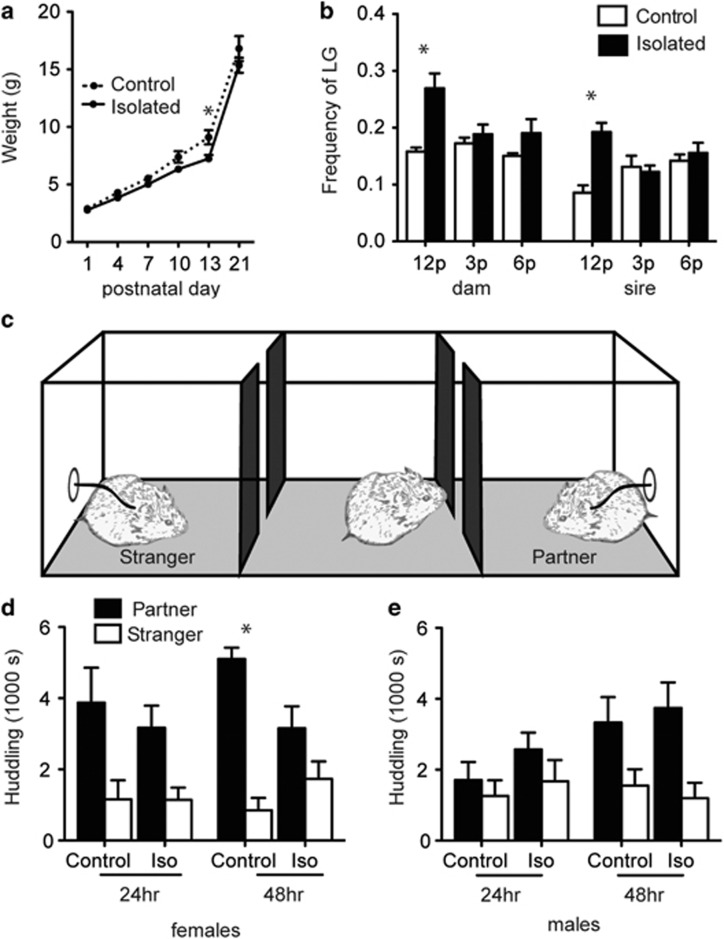
Impact of early isolation on weight, parental care upon reunion and adult behavior. Prairie vole litters were exposed to daily 3h separations from both parents and siblings, or left undisturbed aside from weighing every 3 days. Between PND1–13, weights were averaged across all pups of both sexes within a litter. PND21 weights are averaged across sex. Isolated litters displayed slowed weight gain, and weighed significantly less only on PND13 (a). For 1 h after reunion of the litters, both parents displayed heightened licking and grooming in comparison with controls whose pups were not removed from the nest (b). Adults were tested for their social preference in the partner preference arena (c), reproduced from Barrett and Young.60 Only the control females and early-isolated males displayed a significant partner preference after 48 h of cohabitation (d and e). Asterisk indicates t-test, P<0.05. PND, postnatal day.